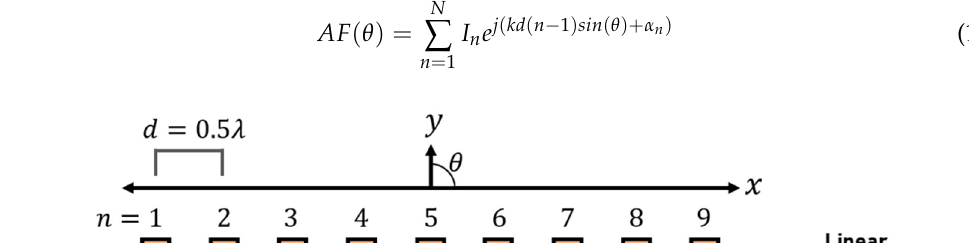
Table 1. Amplification values (at the outputs of the feeding system) that are required to obtain a raised cosine.